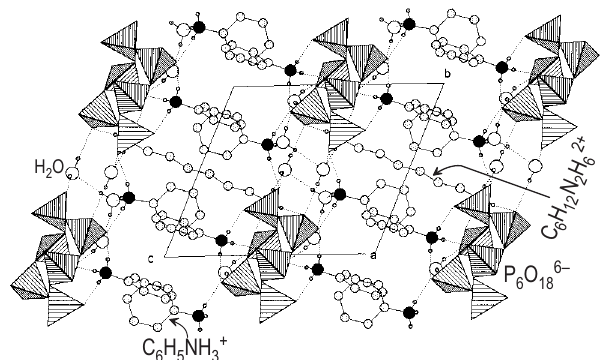
Table 2. Atomic coordinates and displacement parameters (in Å 2 )